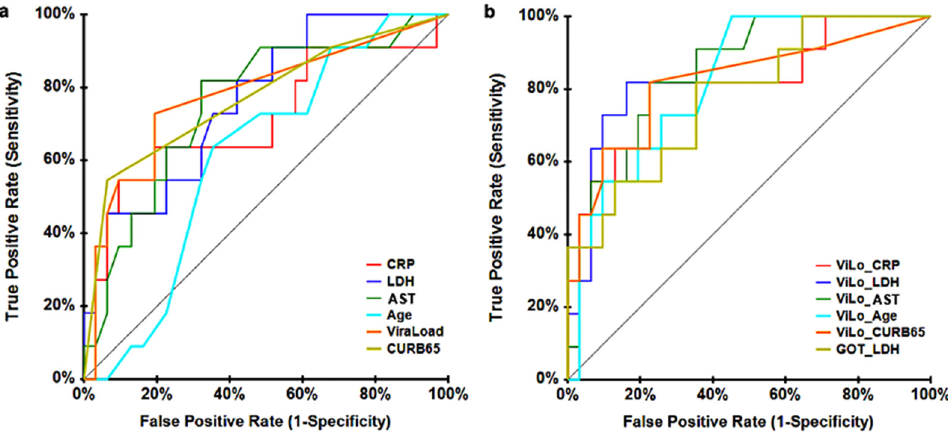
Figure 3. Receiver operating characteristics (ROC) curve analysis of different parameters in COVID-19 patients treated with LDRT to predict COVID-19 mortality. ( a ) ROC plot of single parameters (CRP, LDH, AST, Viral Load, CURB-65, Age). ( b ) ROC plot using a combination of parameters (Viral Load and C-reactive protein, Viral Load and LDH, Viral Load and AST, Viral Load and Age, Viral Load and CURB-65, AST and LDH).